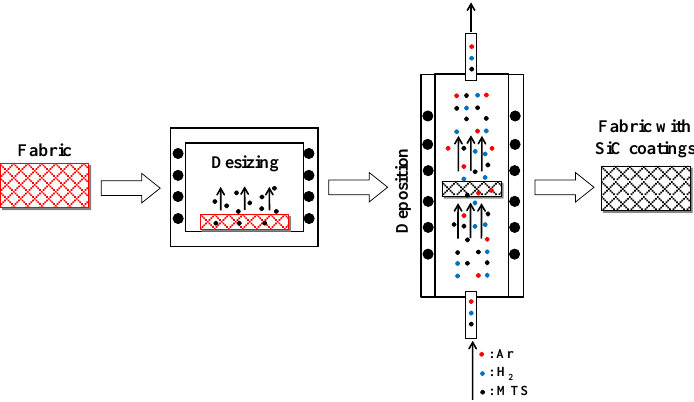
Figure 1. Deposition process of SiC coatings on Nextel TM 440 fibers.